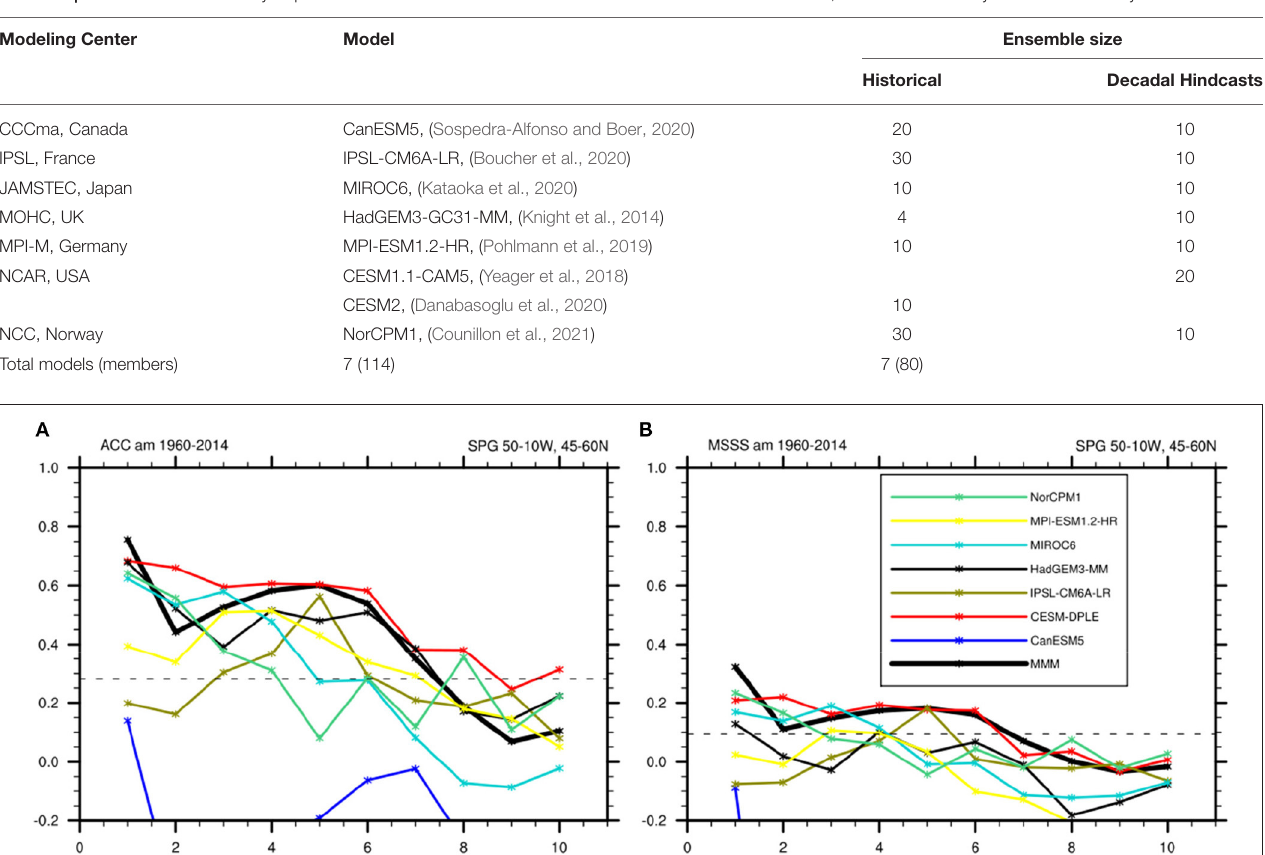
FIGURE 7 | (A) Anomaly correlation coefficient (ACC) for SPG SST in seven initialized CMIP6 model systems (y-axis) against lead time in years (x-axis). (B) as (A) , but showing mean squared skill score (MSSS) on the y-axis. Colors indicate the individual models, the thick black line the multi-model mean. The horizontal dashed line indicates the 95% confidence level compared to climatology based on a two-sided t -test.